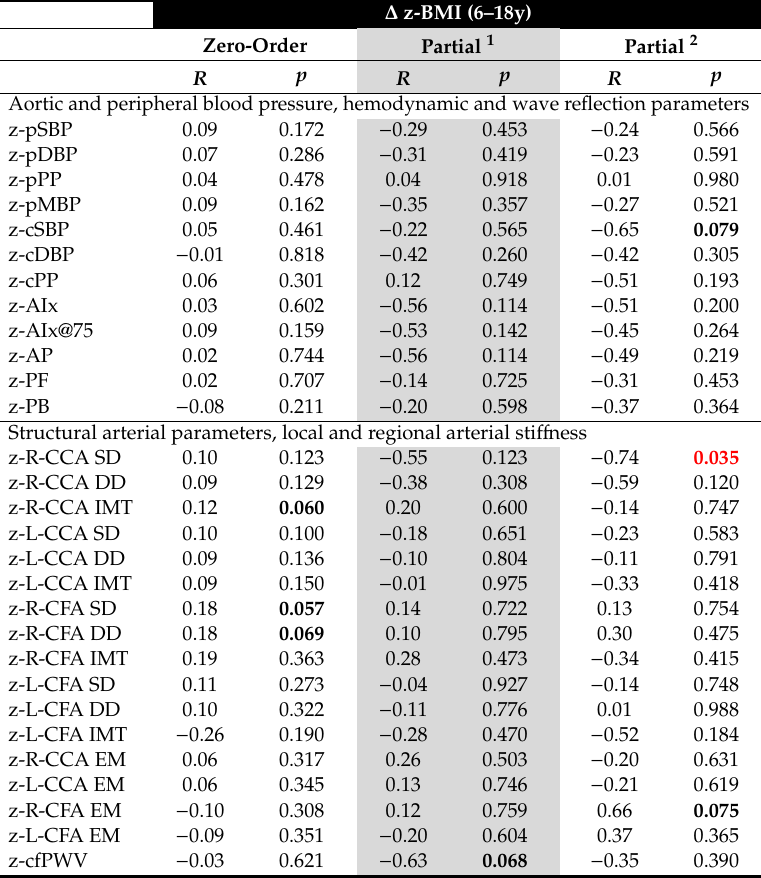
Table 8. Associations between CV z-scores and z-BMI variations between 6–18 y (adolescent cohort, n =